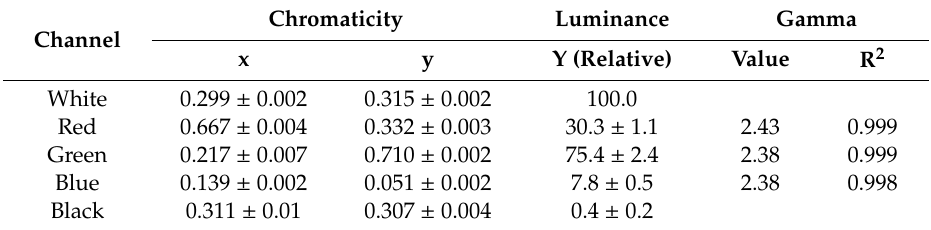
Table 1. The average and standard deviation of CIE 1931 chromaticity and the relative luminance of one point of each display of the HMD measured through the